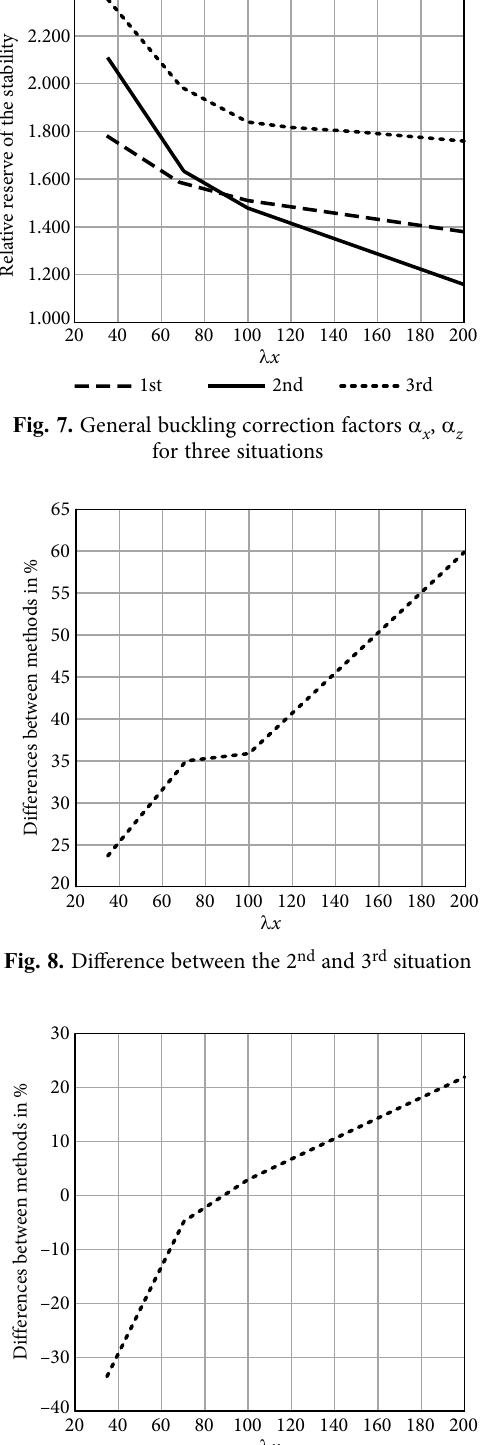
Table 2. The values of general buckling